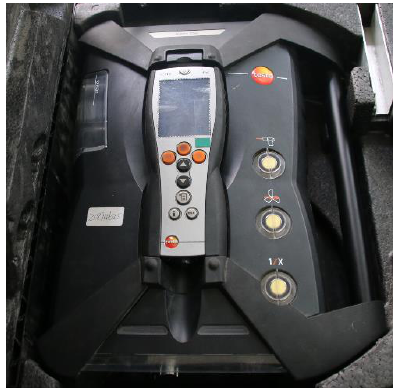
Figure 5. Gas analyzer.